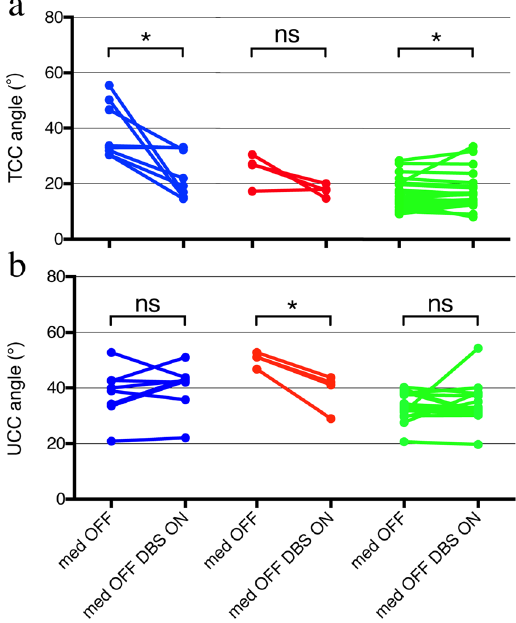
Fig. 2 Improvements in camptocormia angles after surgery. Colored dots represent pre- and post-surgical total ( a ) and upper ( b ) camptocormia angles (TCC/UCC angles) in patients with lower camptocormia (blue symbols and lines), upper camptocormia (red symbols and lines) and without camptocormia (green symbols and lines). * p < 0.05; n.s.: not signi fi cant.